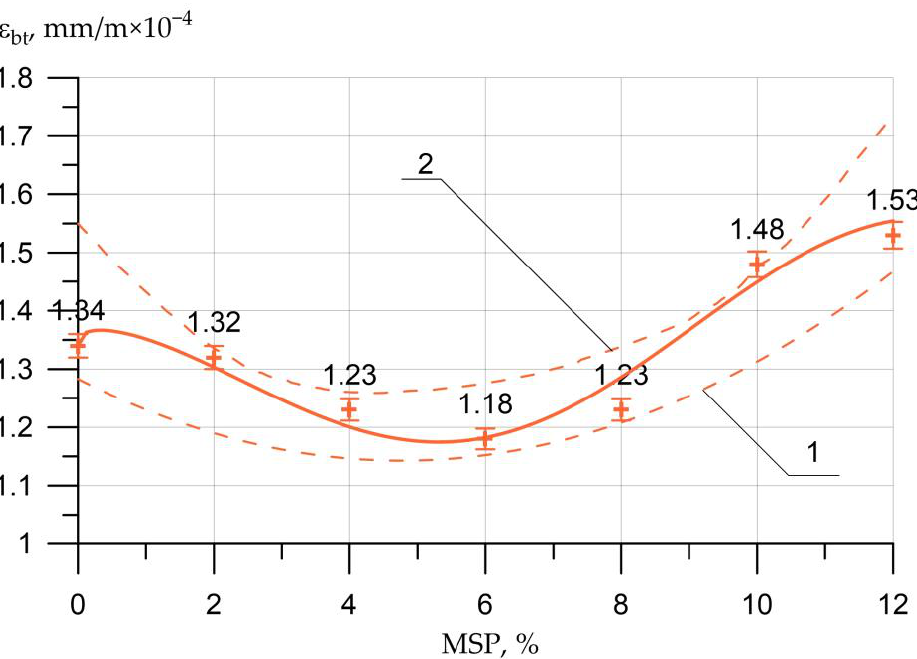
 bt : 1 — lower confi-